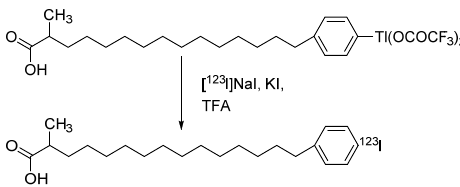
Scheme 39. Synthesis of radioiodinated β -Methyliodophenylpentadecanoic acid (BMIPP)